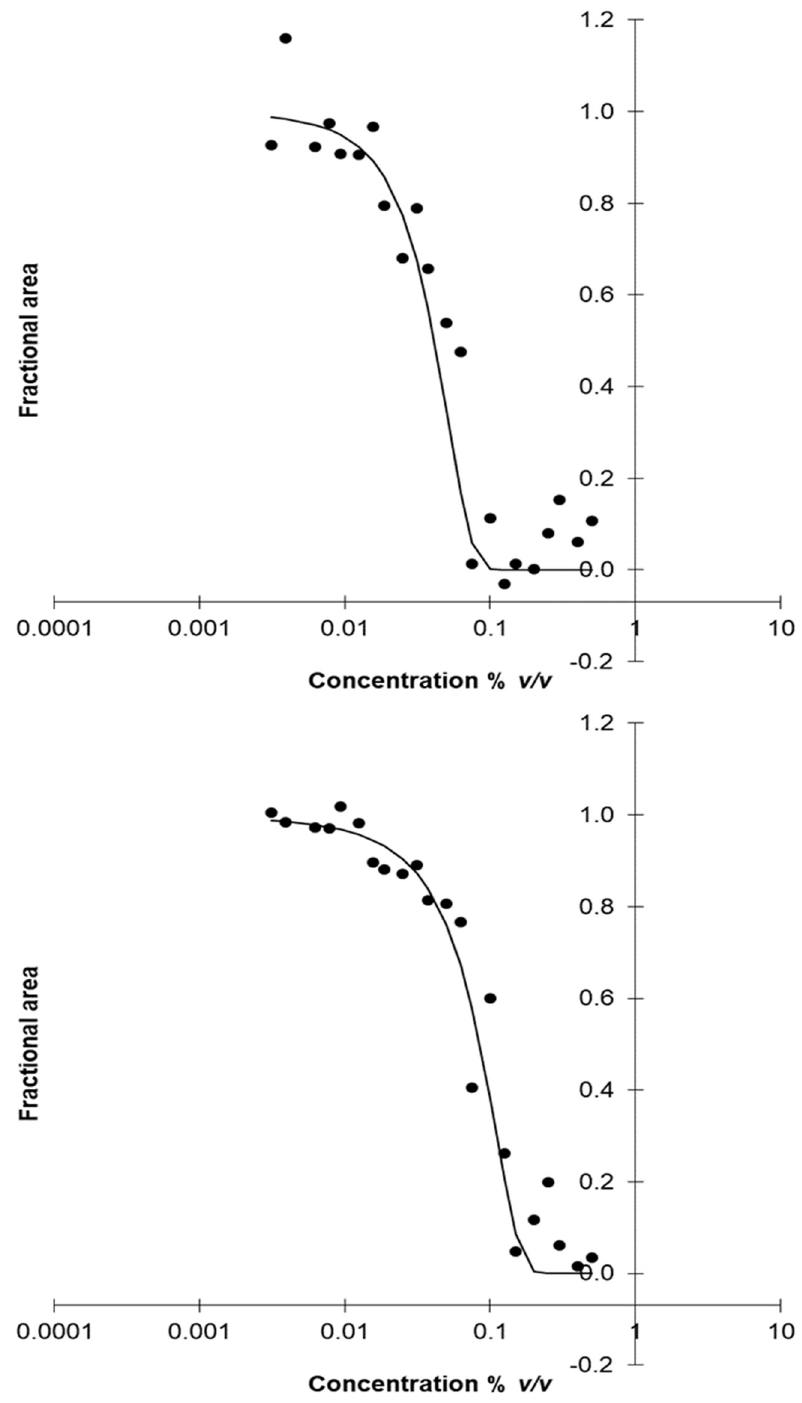
Figure 2. The inhibition profile of Satureja thymbra (C) essential oil against Paenibacillus sp. R2P2 ( upper diagram ) and Penicillium sp. R1R6 ( bottom diagram ) using absorbance measurements; ( • ) observed Fractional Area, (–) predicted Fractional Area.